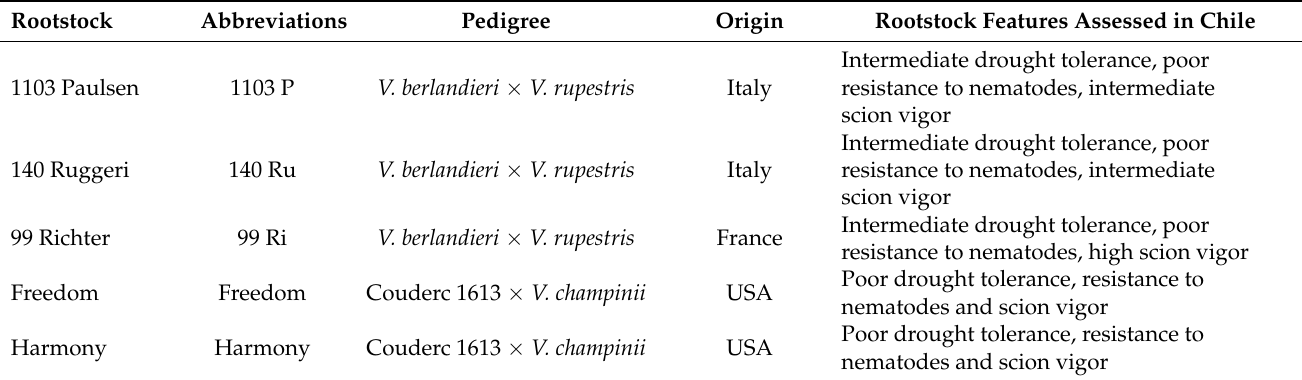
Table 2. Description and abbreviations of the rootstocks under